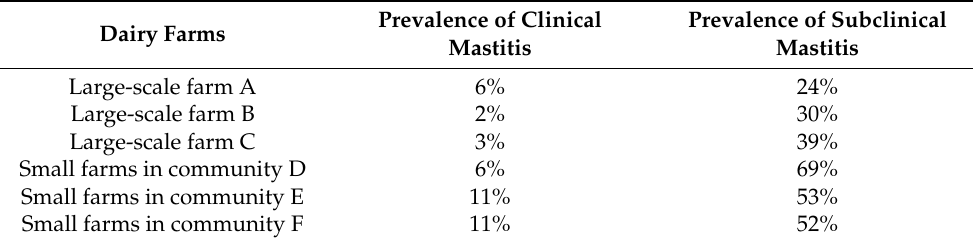
Table 4. The prevalence of mastitis in studied farms in Yunnan, China.